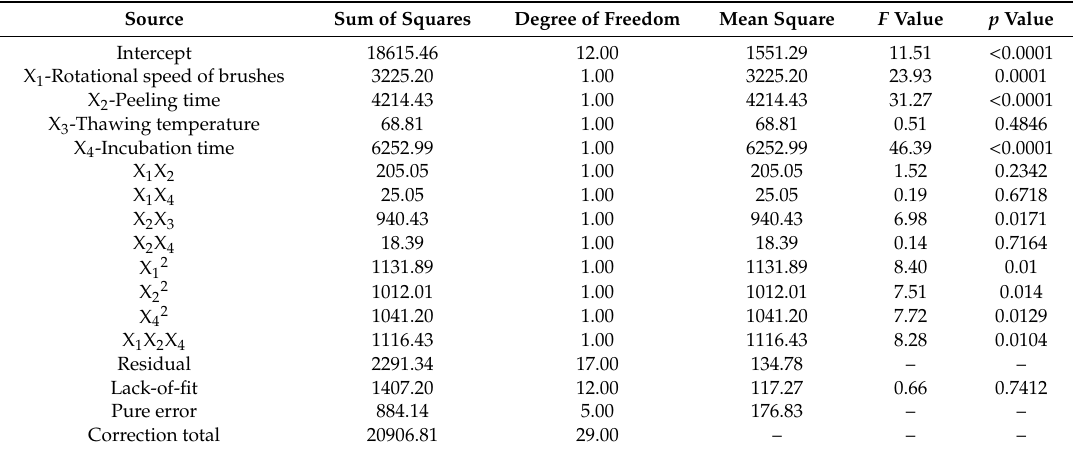
Table 4. ANOVA for reduced cubic equation for the e ff ect of freeze–thaw pre-treatment (FTP), rotational speed of brushes, and peeling time on the peeled surface area (PSA) of cassava